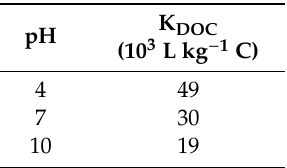
Table 2. Partitioning coe ffi cients of pyrene binding to humic acids (HA) (adapted from